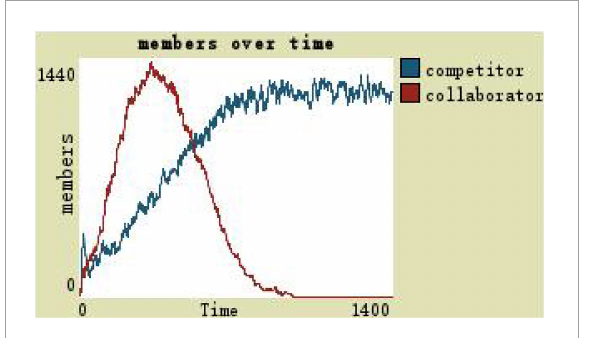
FIGURE5 Changes in team members with the participatory leadership.